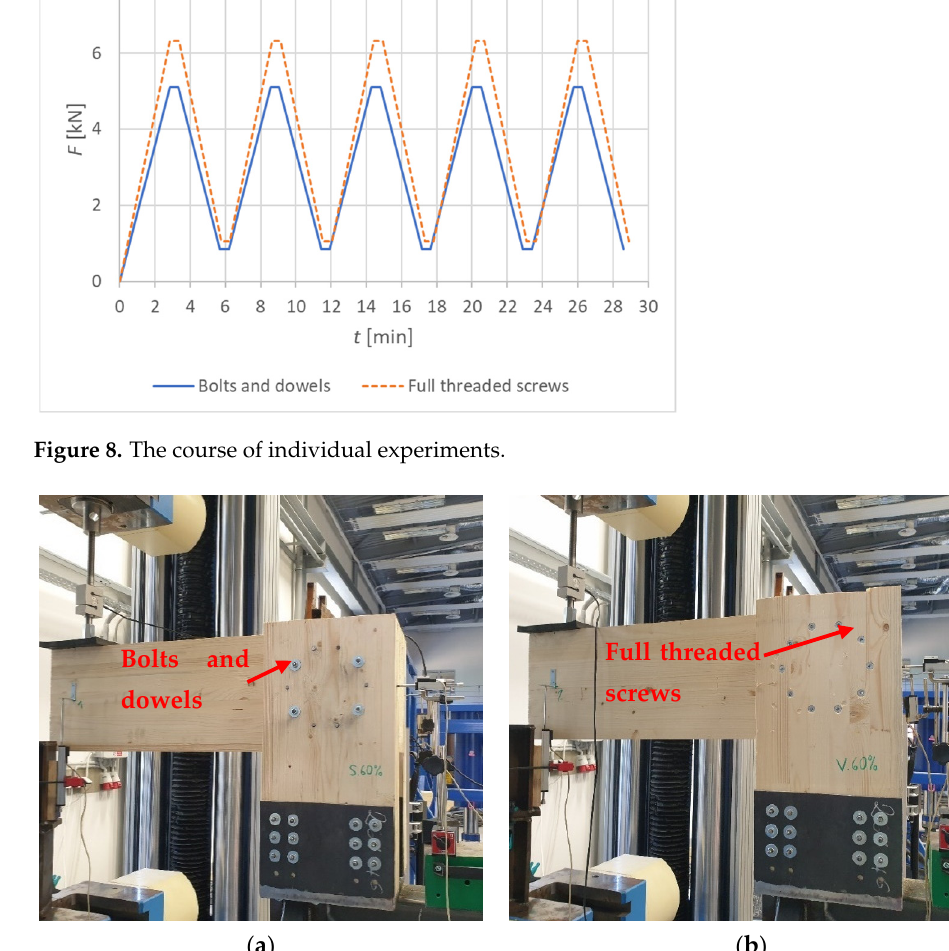
Figure 8. The course of individual experiments.